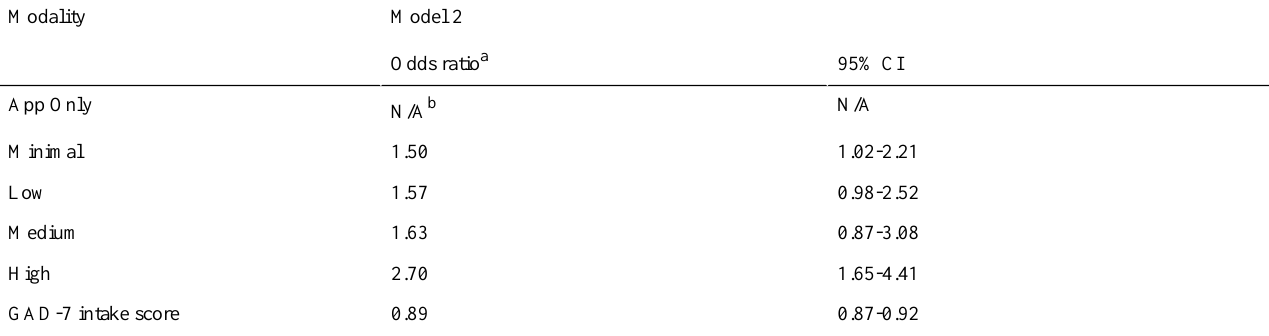
a Odds ratio obtained by exponentiation of the regression coefficients. b N/A: not